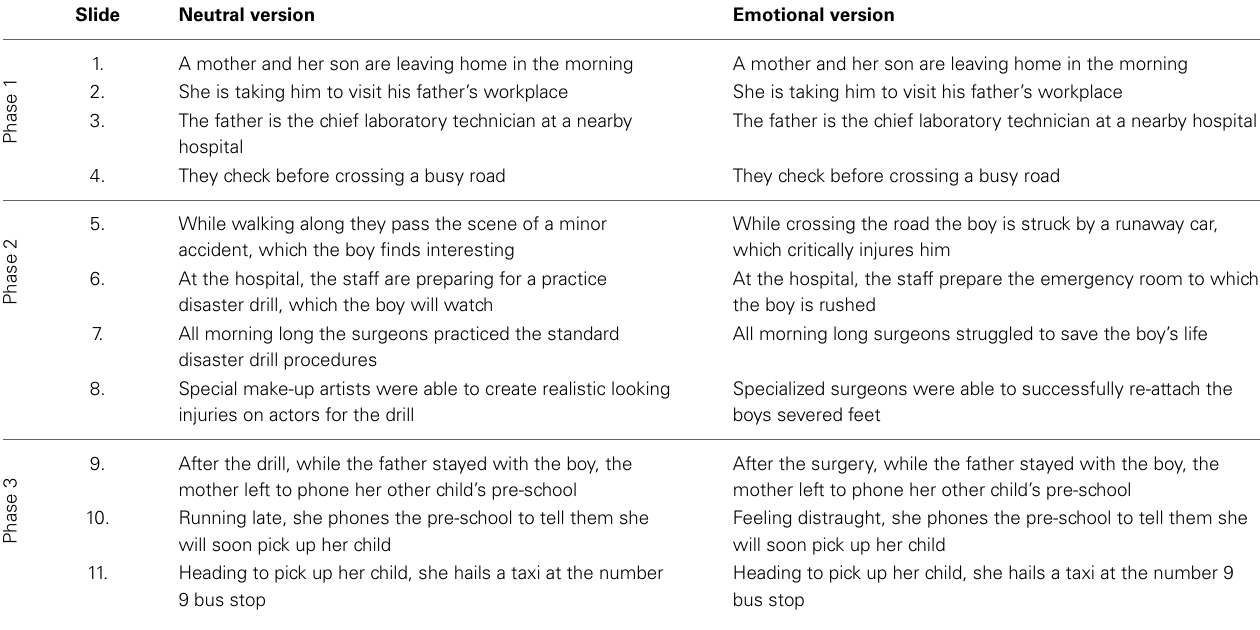
Table 1 | Narratives for the neutral and emotional versions of emotional memory task based on Cahill and McGaugh (1995).